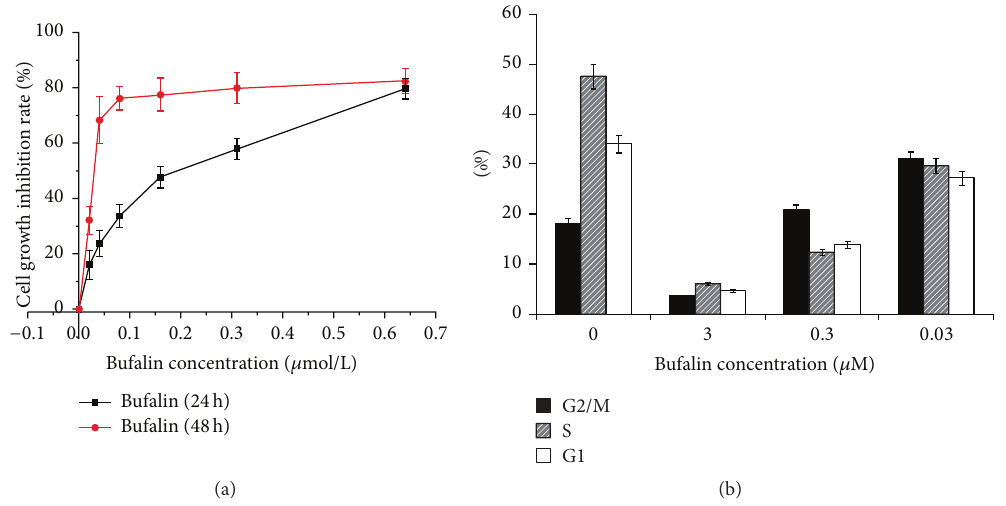
Figure 1: Effects of Bufalin on cell growth and cycle. (a) MTT (3-[4,5-dimethylthiazol-2-yl]-2,5-diphenyl tetrazolium bromide) assay showed Bufalin inhibited the cell growth with time- and dose-dependent manner. (b) Flow cytometric assay revealed that the number of G2/M cells was significantly increased in the Bufalin-treated cells in a dose-dependence manner compared to the controls ( 𝑃 < 0.05